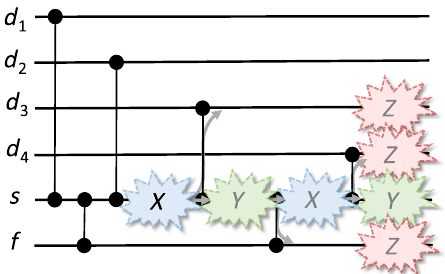
FIG. 5. Propagation of a Pauli- X hook error within the FT PCM circuit inserted between gates d 2 s and d 3 s . At each following ZZ gate, the error on the syndrome itself is alternating between X and Y , while a Z error occurs on the other participating qubits.